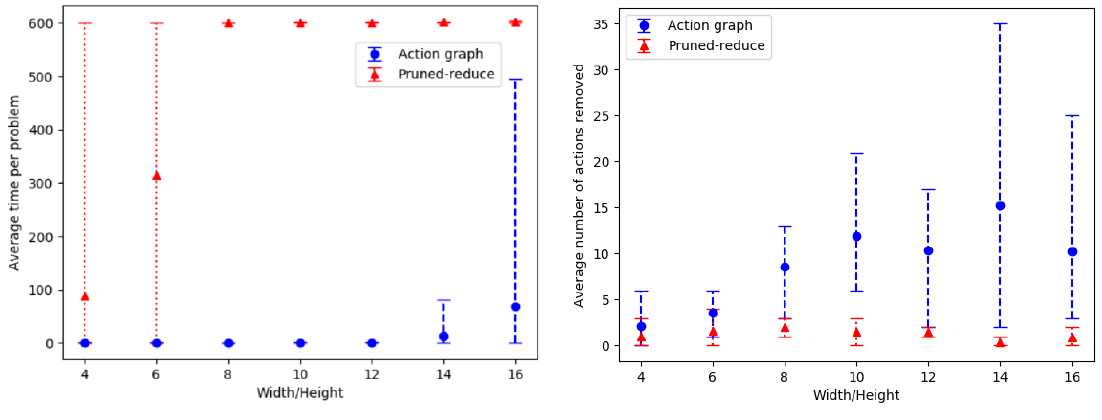
Figure 19. Results for an increasing grid size. The results of our Action Graph approach are indicated by blue circles, pruned-reduce [10] is shown with red triangles. All times are given in